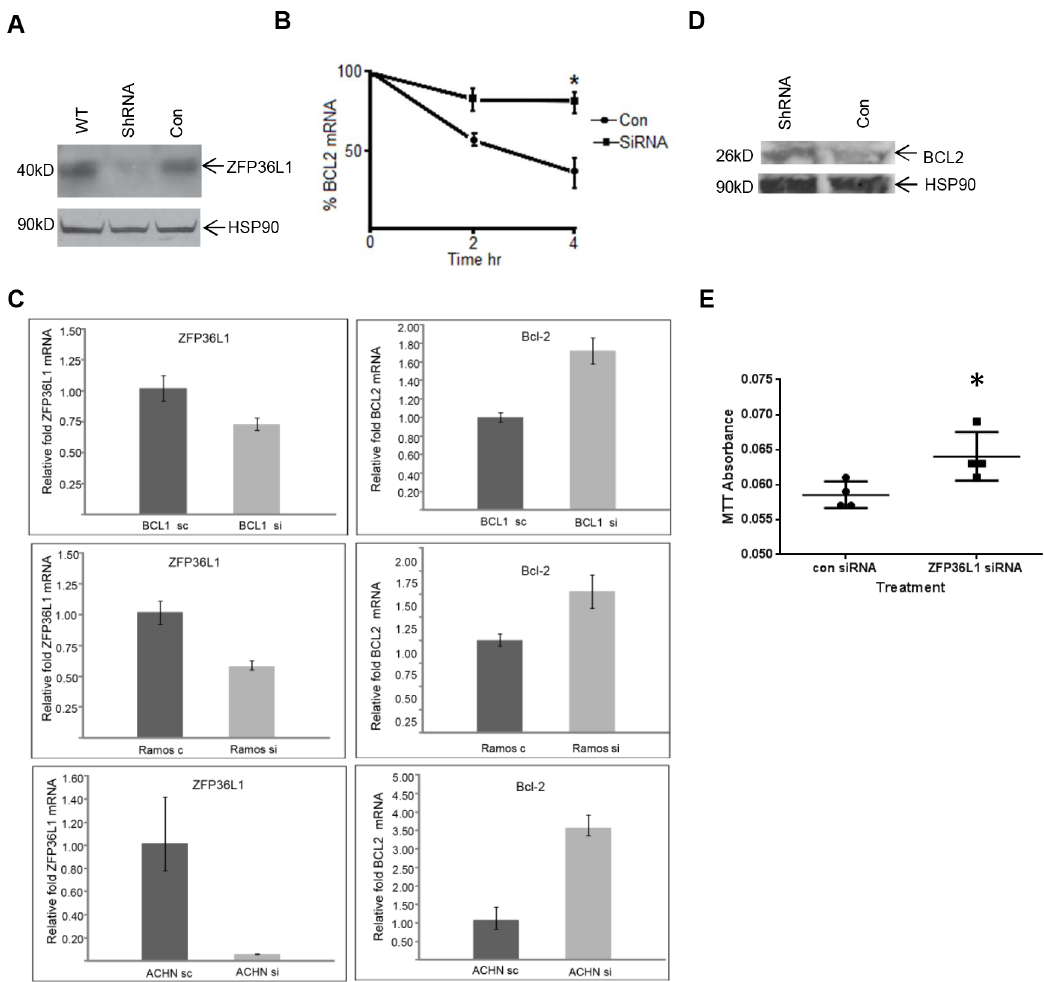
Figure 4. Modulation of ZFP36L1 expression levels is associated with changes in BCL2 mRNA levels in different cell types. (A) Western blot analysis showing Zfp36L1 protein expression in wild-type, ZFP36L1 ShRNA and control empty lentivirus transduced BCL1 cells. Cell Signaling Technology rabbit-anti-human ZFP36L1/L2 antibody was used to detect Zfp36l1 expression. An anti-HSP90 antibody was used as a control for protein loading on the gel. (B) BCL2 mRNA degradation analysis following actinomycin D treatment in Zfp36l1-knockdown and control murine leukemia BCL1 cells. qRT-PCR analysis of Bcl2 mRNA levels over a 4 hour time course in control (empty lentivirus transduced BCL1 cells) and zfp36l1- knockdown BCL1 cells. Cells were treated with 5 m g/ml of actinomycin D for 0, 2, and 4 hours. The results are from 3 independent experiments and show mean 6 SEM. *=p , 0.05 as determined by student T test. (C) ZFP36L1 and BCL2 mRNA levels were measured by qRT-PCR in BCL1, ACHN and Ramos cells. Lentiviral mediated ZFP36L1 ShRNA was used to knockdown ZFP36L1 mRNA levels in BCL1, ACHN and Ramos cells. qRT-PCR analysis was carried out as described in Methods. Control cells were transduced with lentivirus containing scramble sequence (BCL1, ACHN) or empty lentivirus (Ramos). Mean 6 SEM for triplicate samples are shown. These results are representative of at least 2 independent experiments done on each cell type. (D) BCL2 protein expression in ZFP36L1 ShRNA transduced or empty lentivirus (con) transduced Ramos cells. An anti-HSP90 antibody was used as a control for protein loading on the gel. (E) Following either ZFP36L1 or control siRNA oligonucleotide transfection, Ramos cells were treated with ionophore (A23187, 150 nM) and, 24 h later, MTT levels were measured. The results shown are from 4 independent experiments, mean 6 SEM are shown. *=p , 0.05 as determined by student T